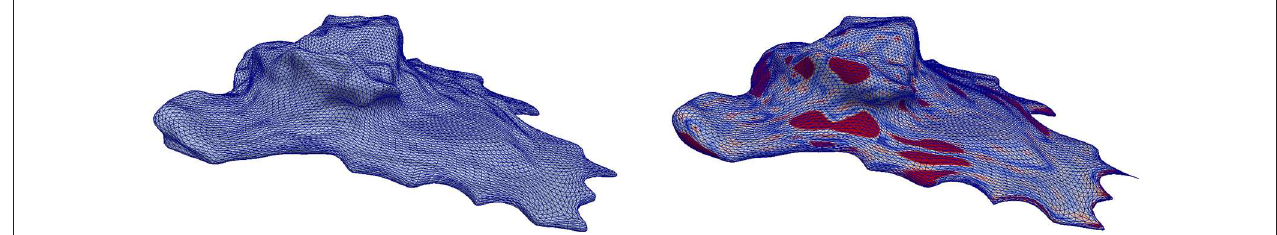
FIGURE 8 | Application of the scheme in Problem 5.1 to a cell surface obtained from image data with the parameters from Table 2 . The color scheme is as in Figure 3 . See section 5.4 for further